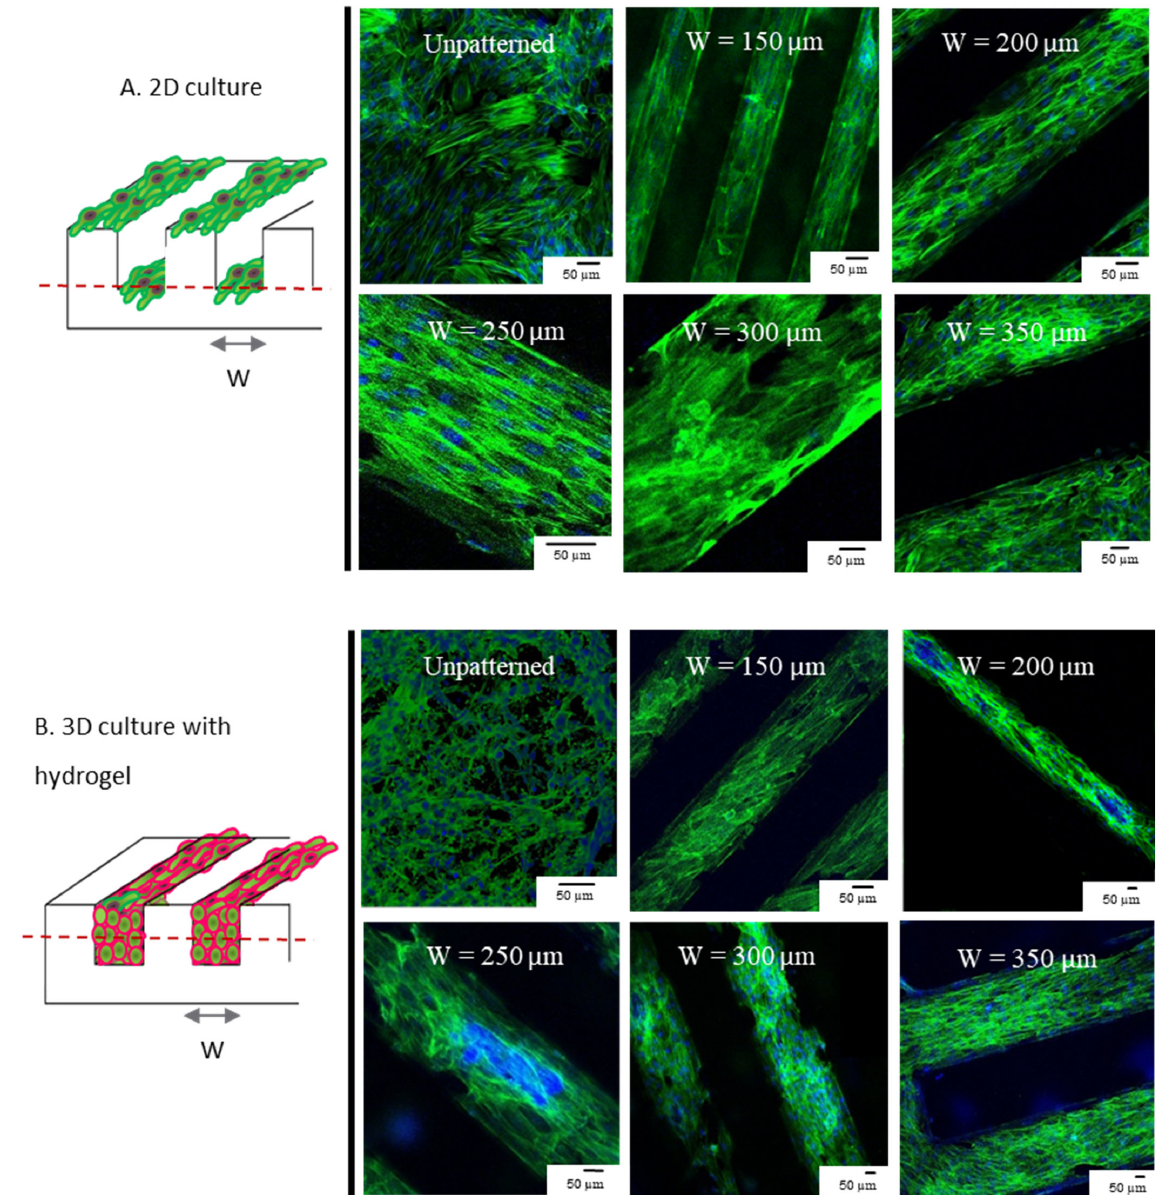
Figure 2. Confocal imaging of cell alignment using microfabricated grooves. ( A ) cells cultured on patterned PDMS molds without hydrogel, creating the 2D stripes. ( B ) cells encapsulated in the dECM ‐ fibrin hydrogel and cultured in patterned PDMS molds in 3D. Cell alignment is observed in all cases, regardless of the structure dimensions, in both 2D and 3D. The red dashed line indicates the confocal image stack. Green: Phalloidin, Blue: DAPI.